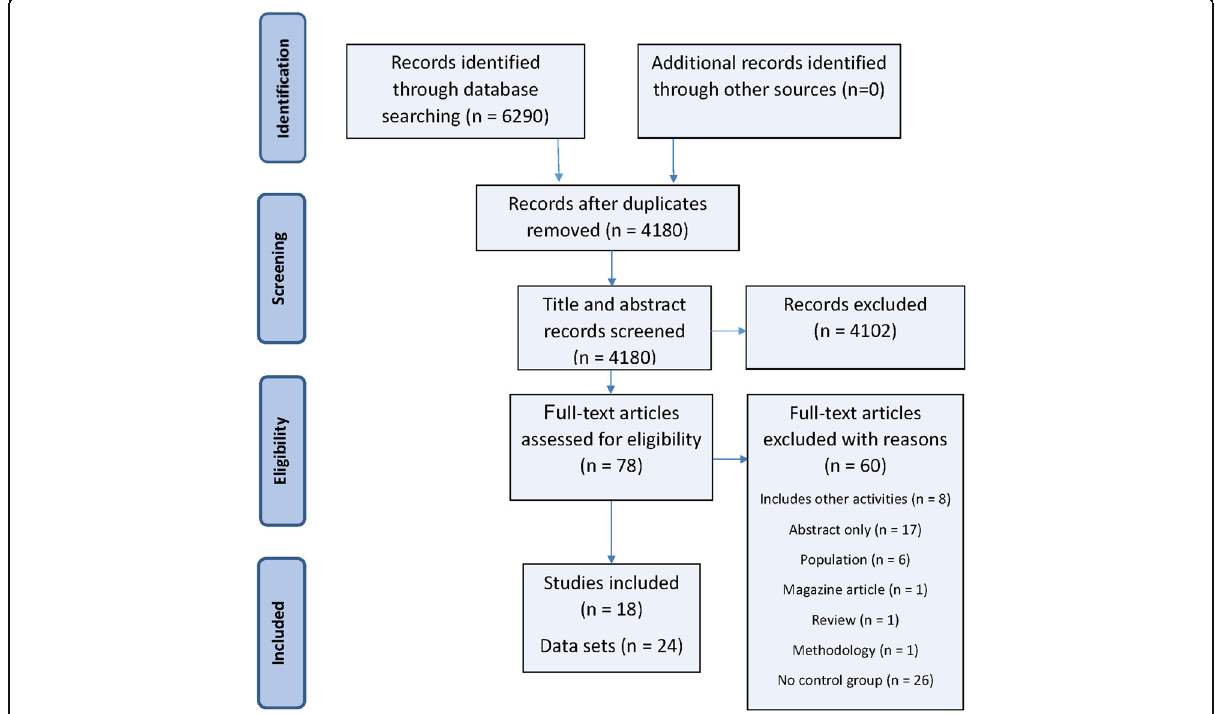
Fig. 1 PRISMA flow diagram of systematic search and included studies